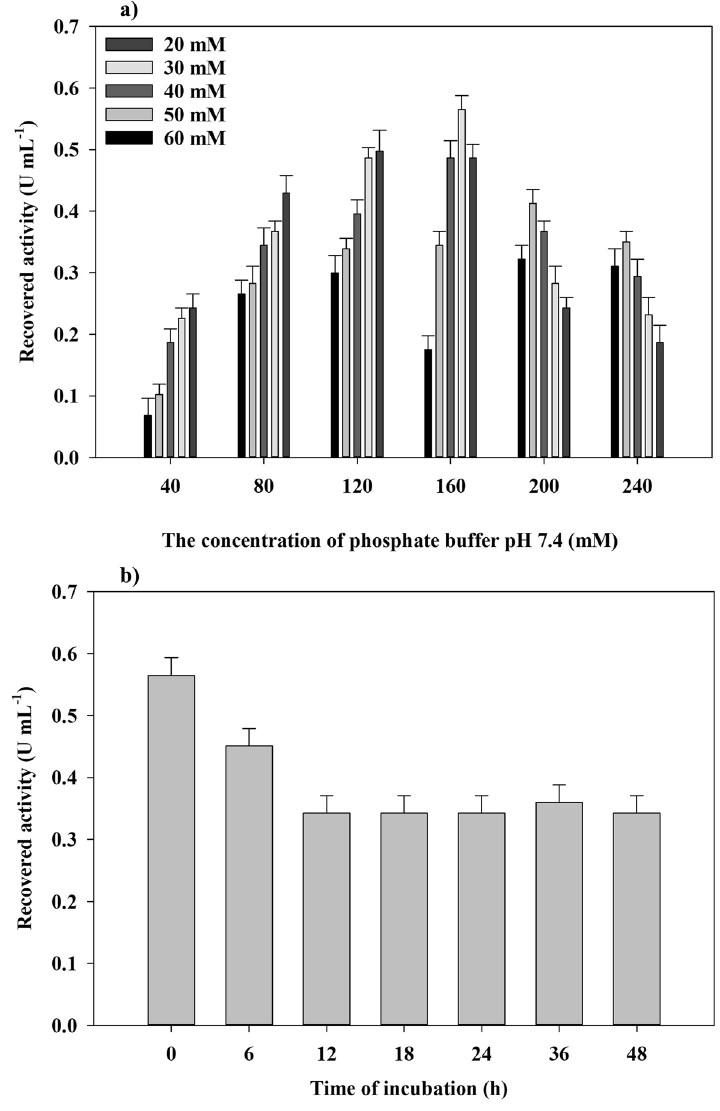
Figure 1. Optimization of the synthesis procedure. The synthesis of laccase@Co 3 (PO 4 ) 2 •HNFs by optimizing the concentration of phosphate and cobalt (II) ions ( a ), the influence of incubation (at 25 °C) as traditional procedures for the construction of HNFs on the recovered activity of the heterogeneous biocatalyst ( b